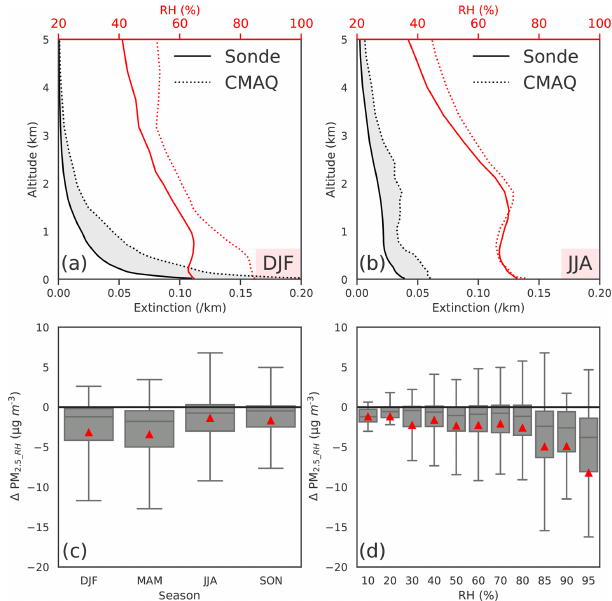
Figure 9. (a) DJF and (b) JJA average vertical profiles of the CMAQ modeled versus observed RH at six atmospheric soundings over the northeastern US, and the modeled extinction versus that cal- culated by replacing modeled RH with observed values. The gray area shows the difference in the two extinction profiles, with the total area being the difference in AOD. (c) Box plots showing the impacts of model bias of RH on the derived PM 2 . 5_MAIAC ( (cid:49) PM 2 . 5_RH ) in four seasons of 2011, which are calculated by comparing the PM 2 . 5_MAIAC minus the one calculated using ob- served RH. (d) Box plots show the influence of model RH biases on the derived PM 2 . 5_MAIAC ( (cid:49) PM 2 . 5_RH ) as a function of observed near-surface RH.